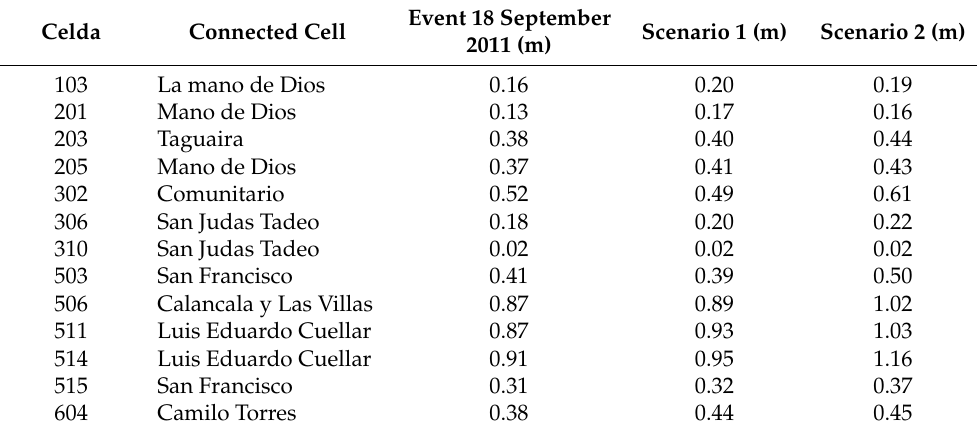
Table 5. Comparison of water elevations/depths obtained with IBER in both scenarios considered (and, for reference, in the event of September 2011 used for calibration).